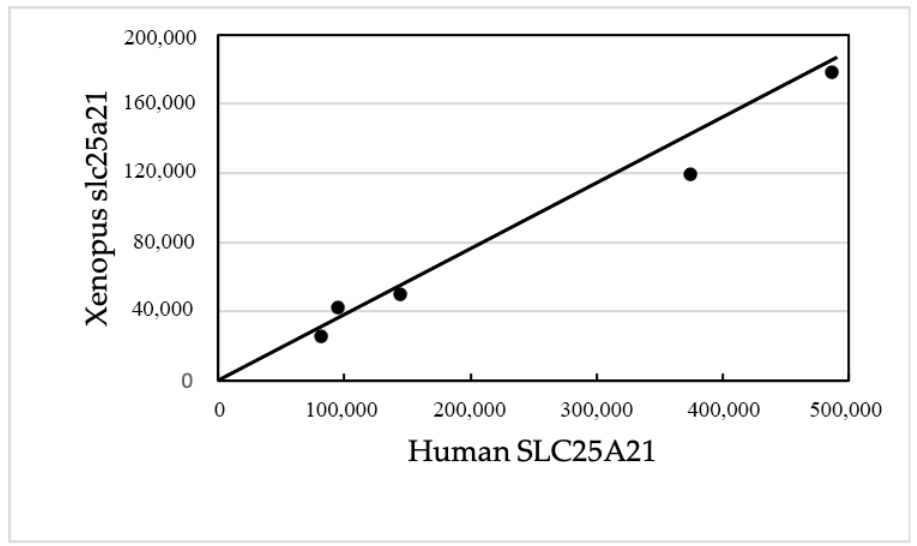
Figure 5. Abscissa: Human SLC25A21 (490,793 nucleotides). Ordinate: Xenopus slc25a21 (187,108 nu- cleotides). The matching points do not correspond to TEs and significantly align along the diagonal from the lower left corner to the upper right corner. Aligned nucleotides = 846 over 187,108, i.e., 0.45%.